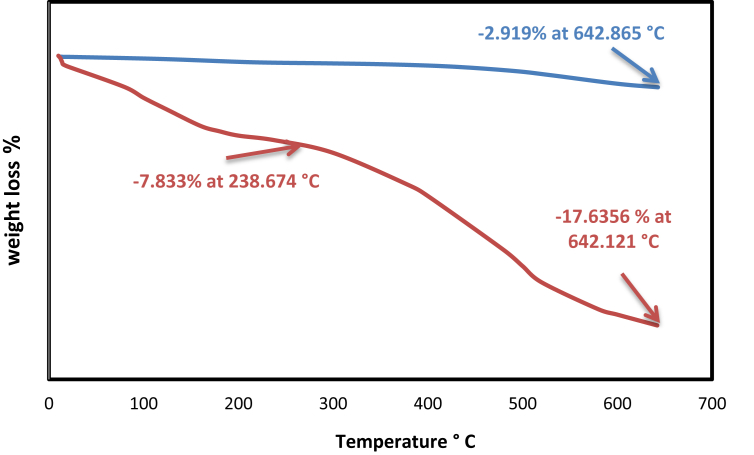
Thermal gravimetric analysis for SBA-15 and NH2-SBA-15.